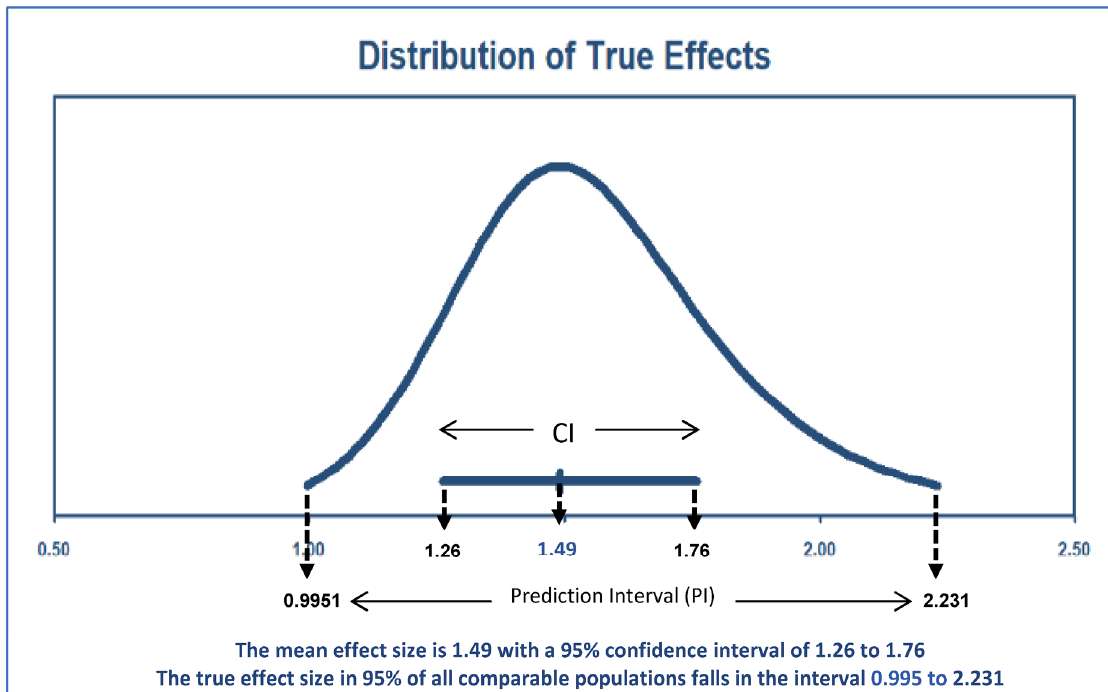
Figure 5. 95% confidence interval (CI) and Prediction Interval (PI) for the effect estimate.